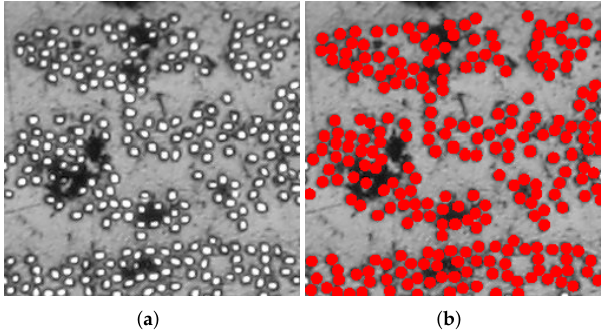
Figure 7. Application of the proposed algorithm in a cropped region of specimen TE-90-4-1: ( a ) re- production of a cropped region from original micrograph used for computing the microstructure and ( b ) computed microstructure using the proposed algorithm. The computed fiber volume fraction is V f = 31.96%.